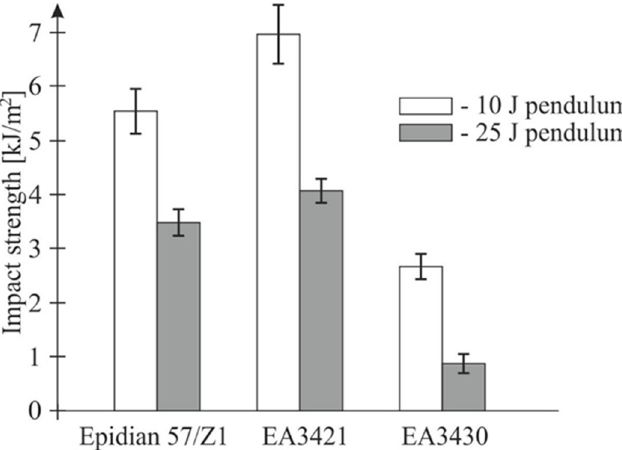
Figure 3. Impact strength of three adhesives for V = 3.81 m/s, using the pendulums of 10 J and 25 J .